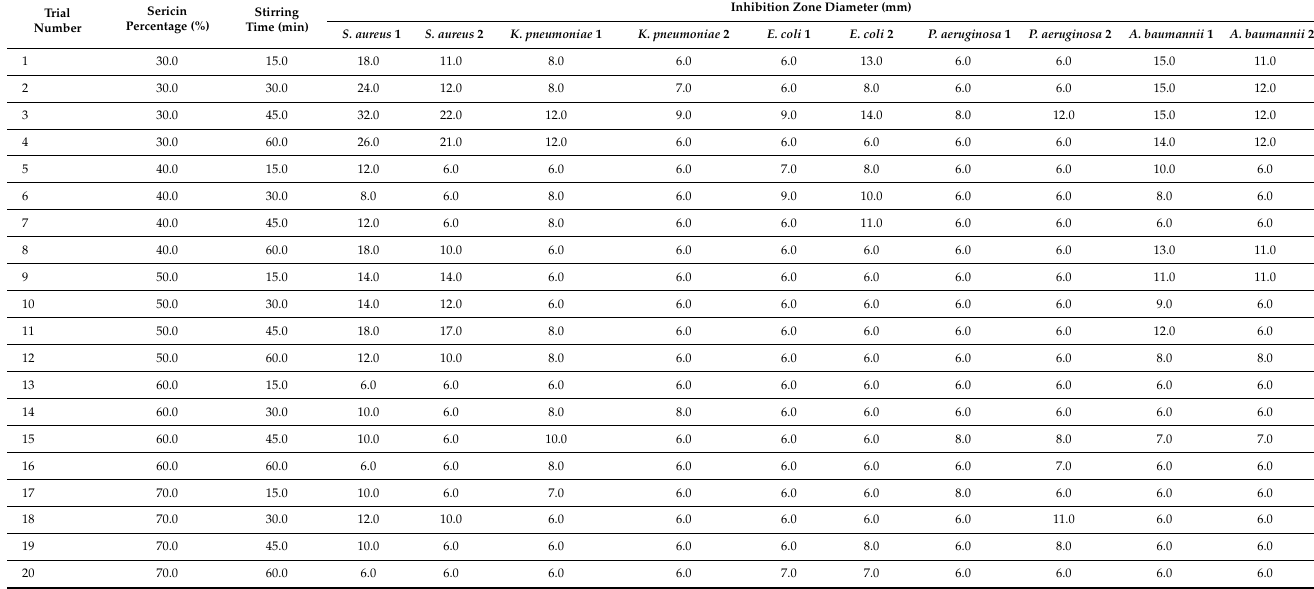
Table 4. Optimization of the antibacterial activity of the synthesized nanoformulae against sev- eral pathogens.